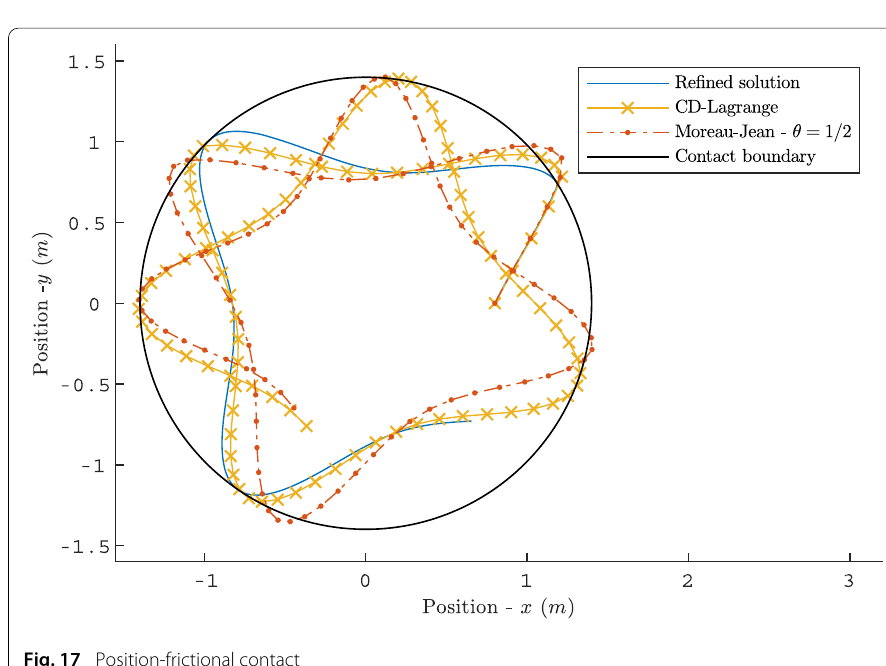
Fig. 17 Position-frictional contact